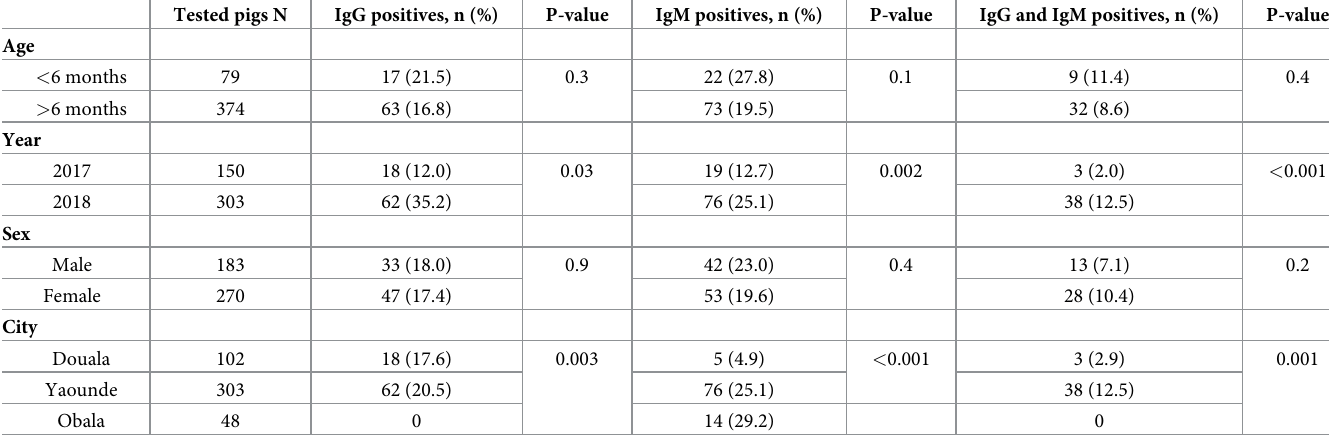
Table 2. Seroprevalence of HEV infection by different factors. Tested pigs